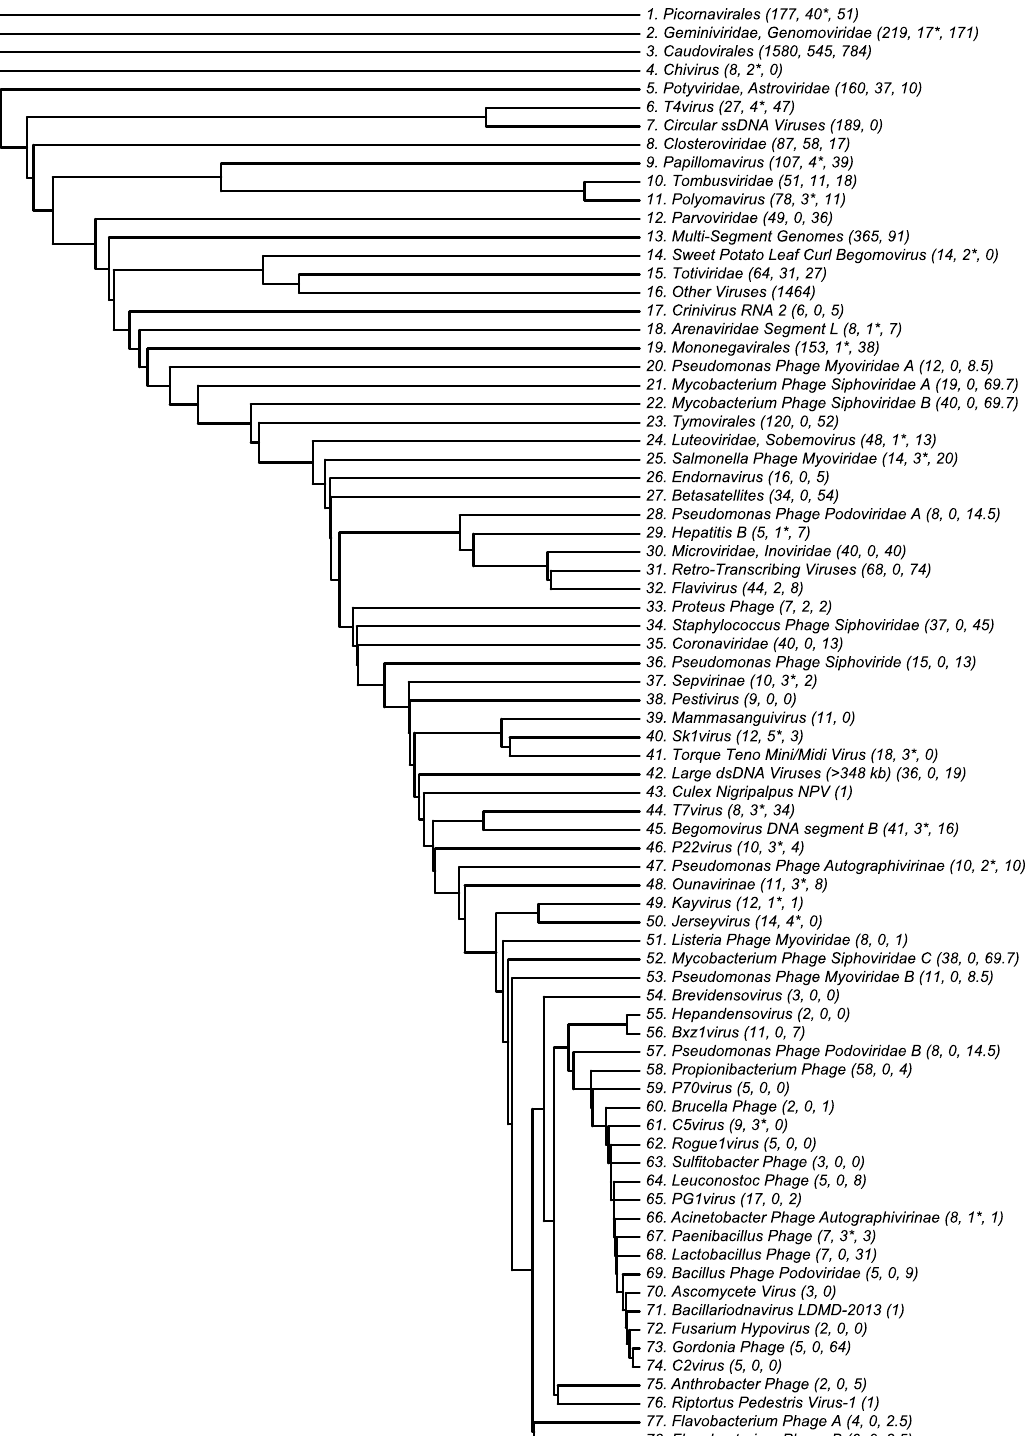
Fig 5. Dendrogram of 78 clusters of viruses, determined by density-based clustering on the 3-dimensional t-SNE space of viral genomes. Cluster numbers correspond to numbers in Fig 4. Three numbers are given in parentheses: the number of viruses in each cluster, the number of viruses which are not part of the family but nevertheless are clustered together with it, and the number of viruses in a family which were not included in its cluster. Asterisks after the second number indicate that most of the incorrect viruses are unclassified by ICTV or otherwise correspond weakly with it. In a few cases, one family was split into multiple clusters; in these cases, the clusters were designated “A,” “B,” etc. If